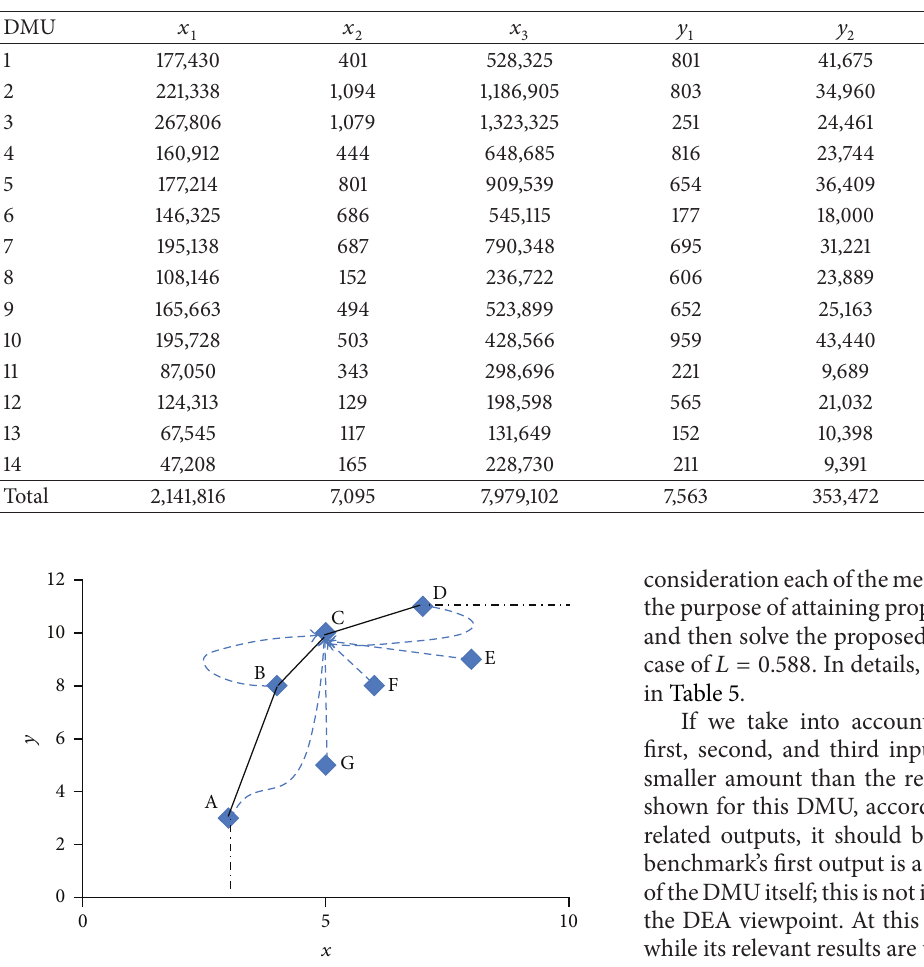
Table 4: Data related to 14 gas companies.